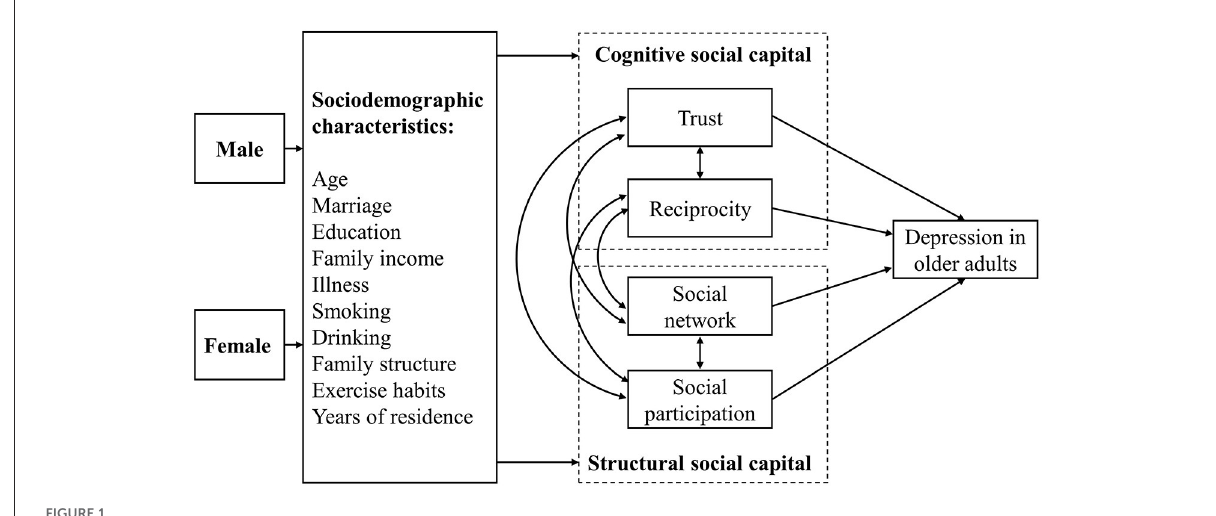
FIGURE1 Hypothetical